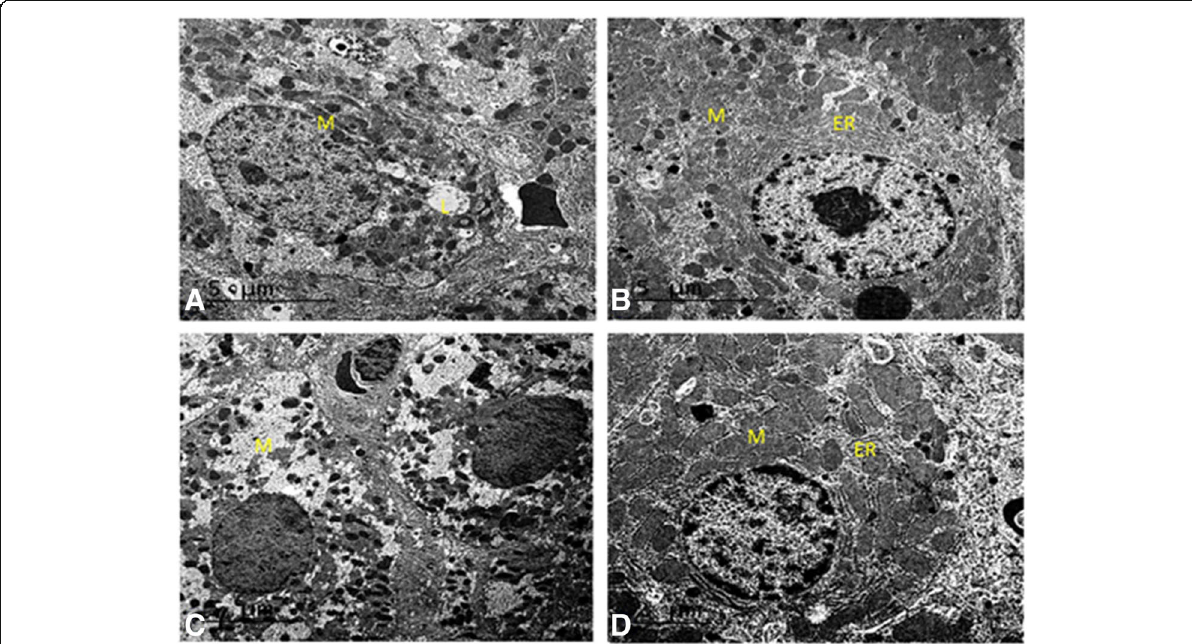
Fig. 6 a An electron micrograph of 500 mg/kg body weight COC-treated rat liver for 90 days showing necrotic liver cell with the nuclear chromatin beginning of losing and losing mitochondria and elongating of some mitochondria (M), mild dissolution of the cytoplasm, and appearing of lipid droplets (L). b An electron micrograph of 500 mg/kg body weight COC- and curcumin 80 mg/kg-treated rat liver for 90 days showing normal hepatocyte with increasing number of mitochondria (M) and rough endoplamic reticulum (ER). c An electron micrograph of 2000 mg/kg body weightCOC-treated rat liver for 90 days showing a dissolution of the cytoplasm with degeneration to most organs of cytoplasm and mitochondria (M), an abnormal nucleus with loss of chromatin. d An electron micrograph of 2000 mg/kg body weight COC- and curcumin 80 mg/kg-treated rat liver for 90 days showing normal hepatocyte with increasing number of mitochondria (M) and rough endoplamic reticulum